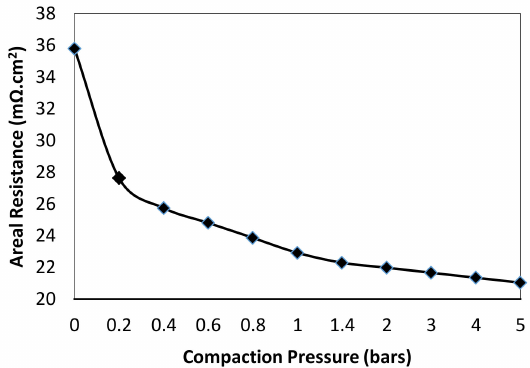
Figure 5. Areal resistance of three-layer expanded graphite (EG) composite at various compaction